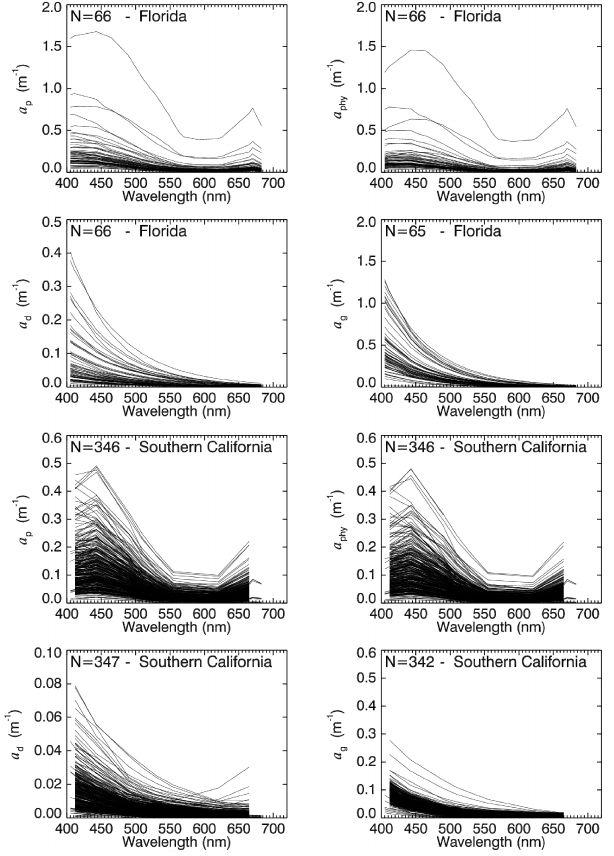
Figure 14. The match-up field absorption spectra provided from the Florida (upper panel) and southern California (bottom) sites.